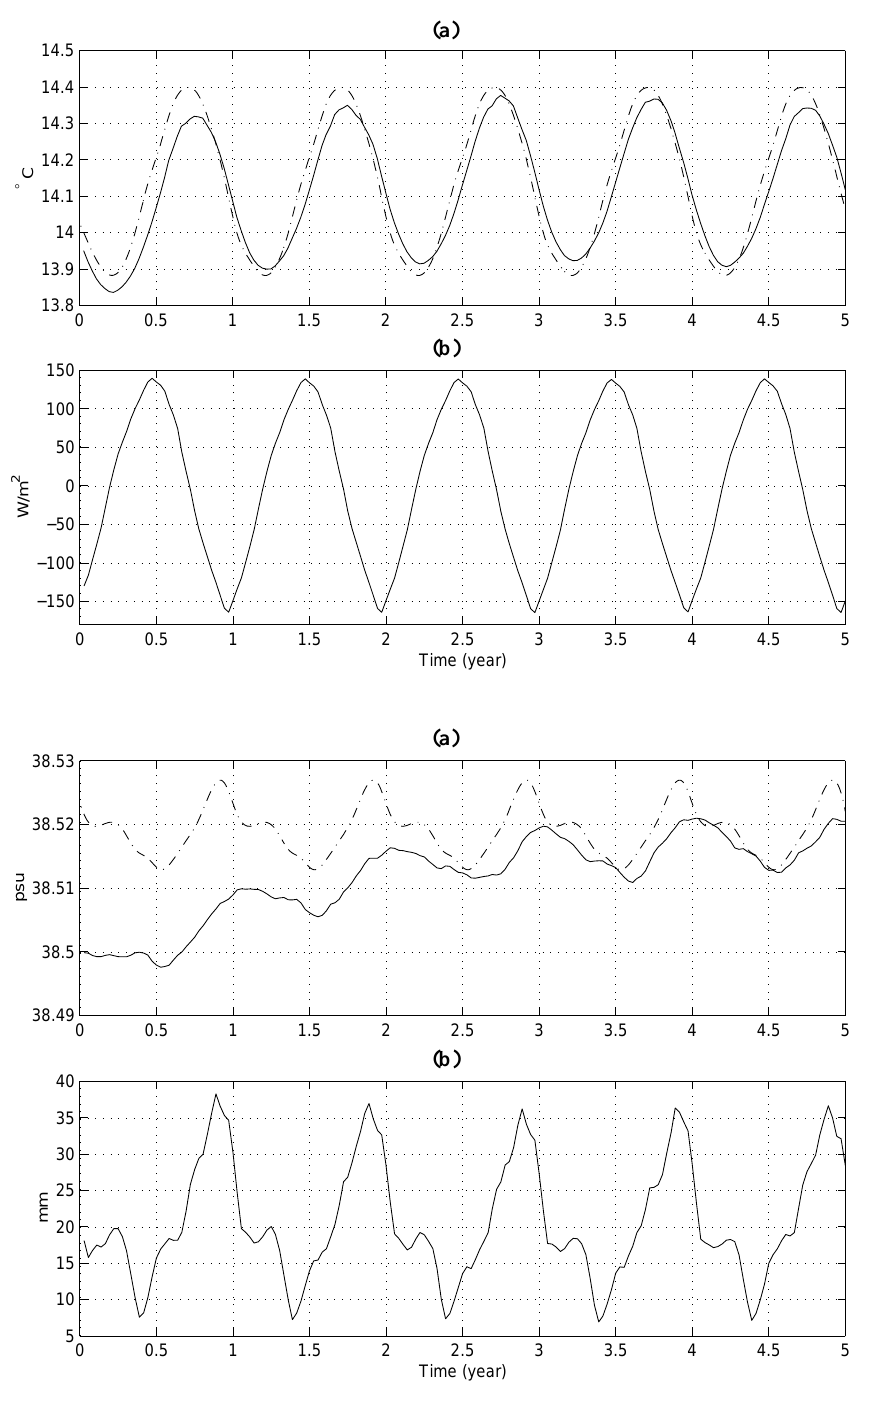
Fig. 8. (a) Comparison between the modelled (solid line) and Med6 clima- tology (dotted line) time series of salin- ity; Units are psu. (b) Time series of the modelled surface water flux. Units are